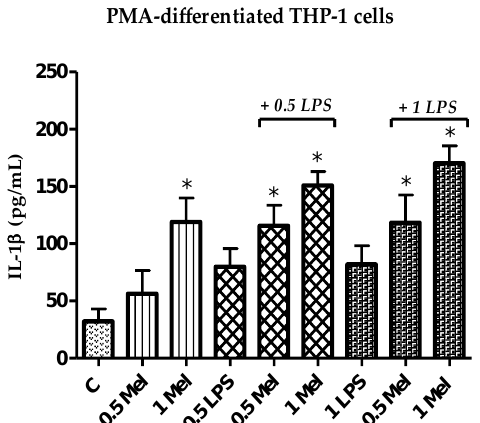
Figure 3. Effect of melittin on the production of Interleukin-1 β (IL-1 β ) cytokines by PMA-differentiated THP-1 cells in the presence and absence of LPS. Cells treated with all four combination treatments showed significantly higher release when compared with negative control cells ( n = 3). C: control; Mel: melittin; LPS: lipopolysaccharides; *: Significant ( p < 0.05).